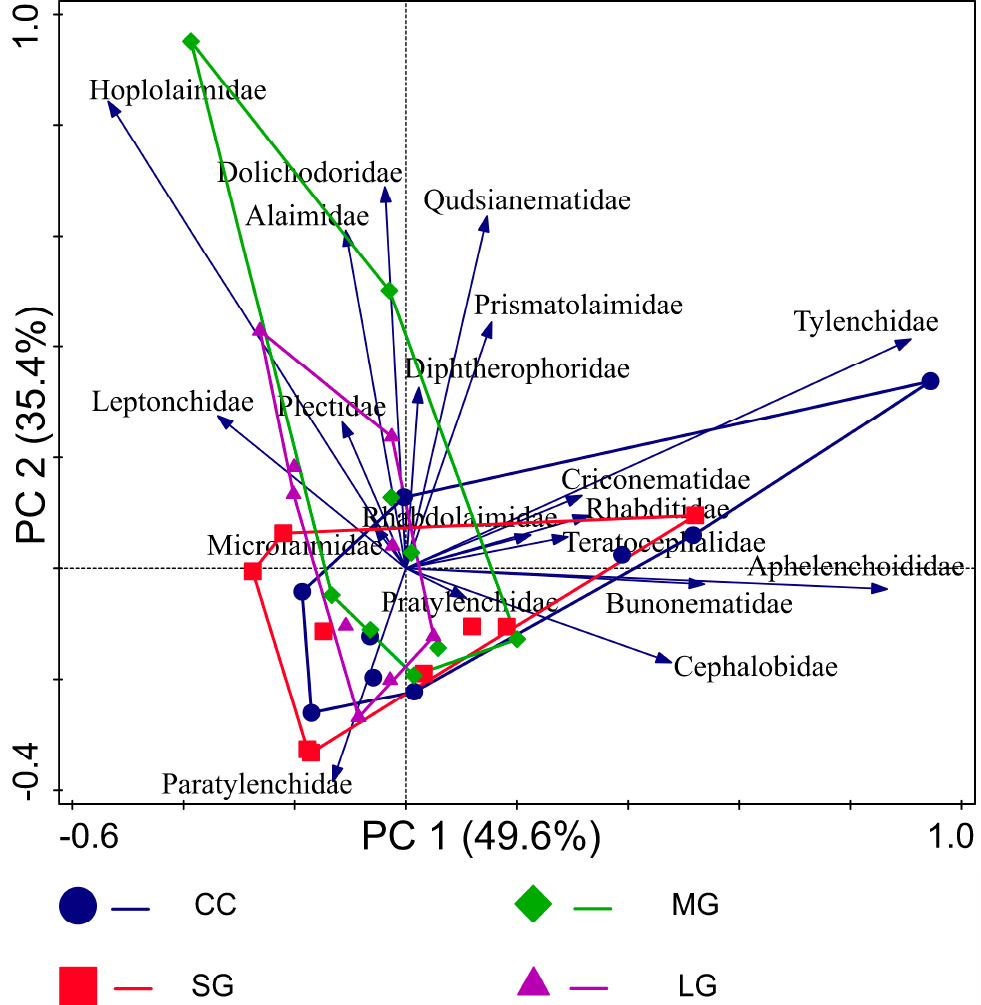
Figure 1. Variations in community structure of the soil nematodes in four treatments. CC, closed canopy; SG, small gaps; MG, medium gaps; LG, large gaps.